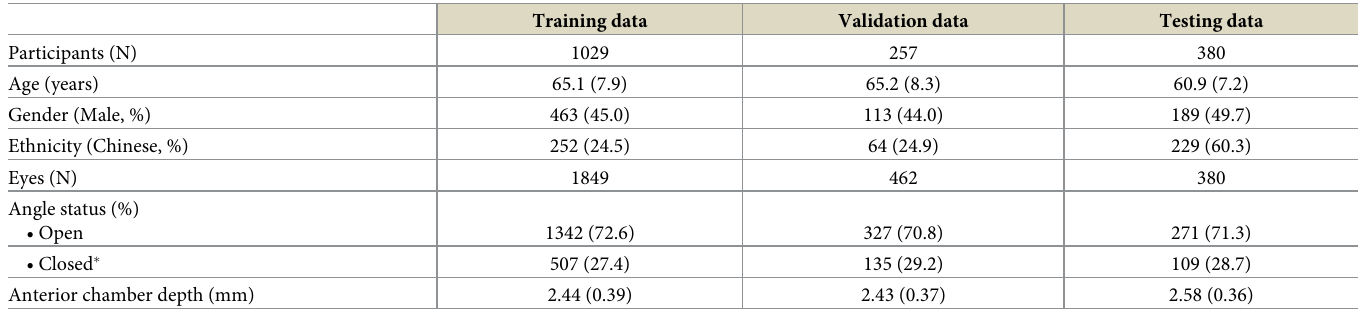
Table 1. Demographic and ocular characteristics of participants included in this